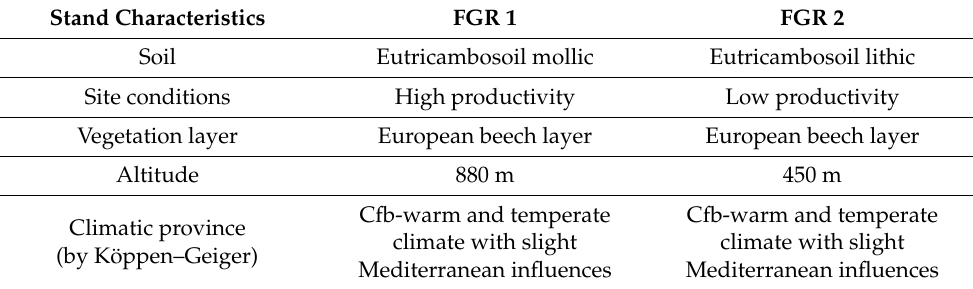
Table 1. Cont. Stand